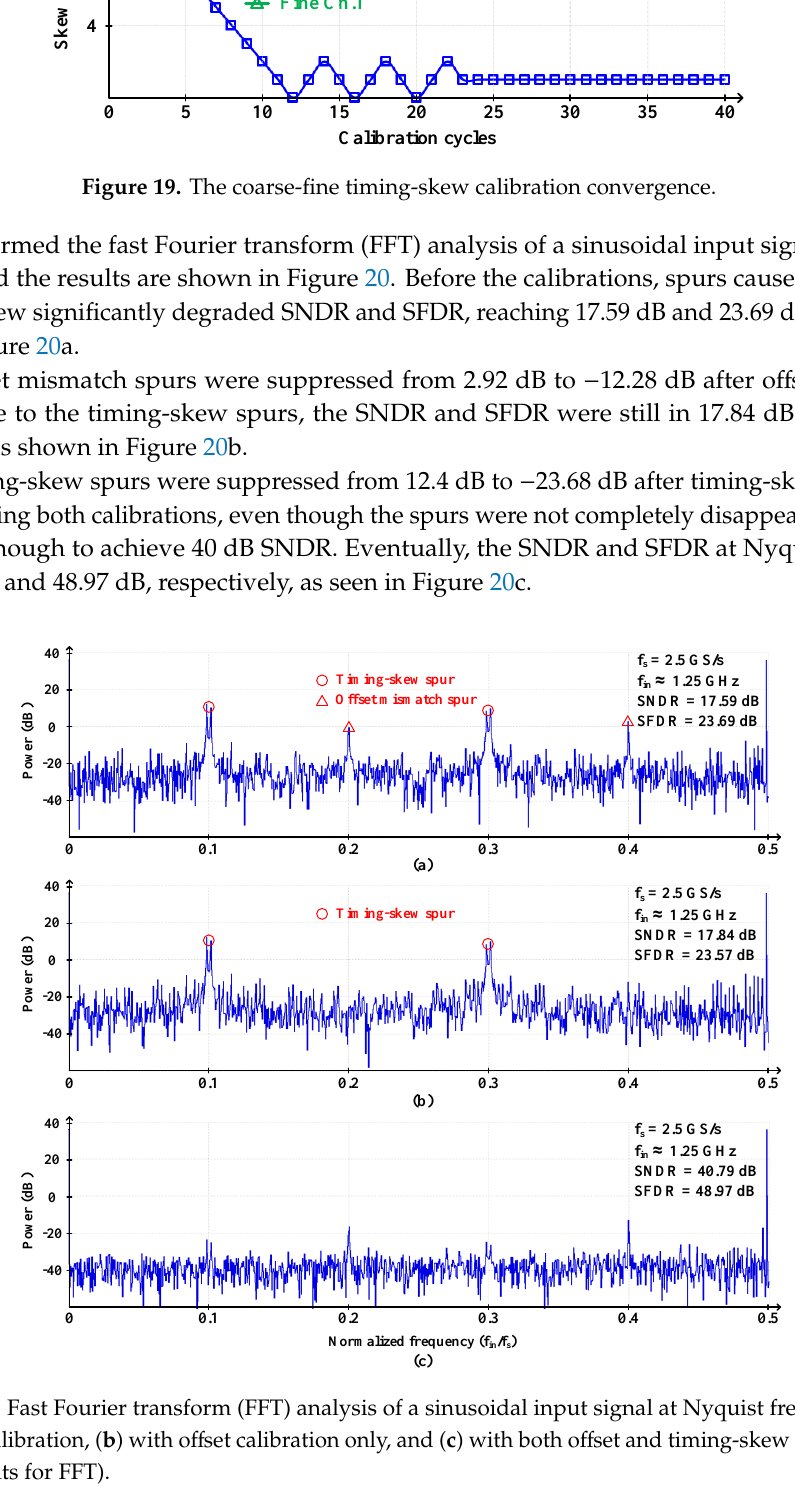
Figure 19. The coarse-fine timing-skew calibration convergence.